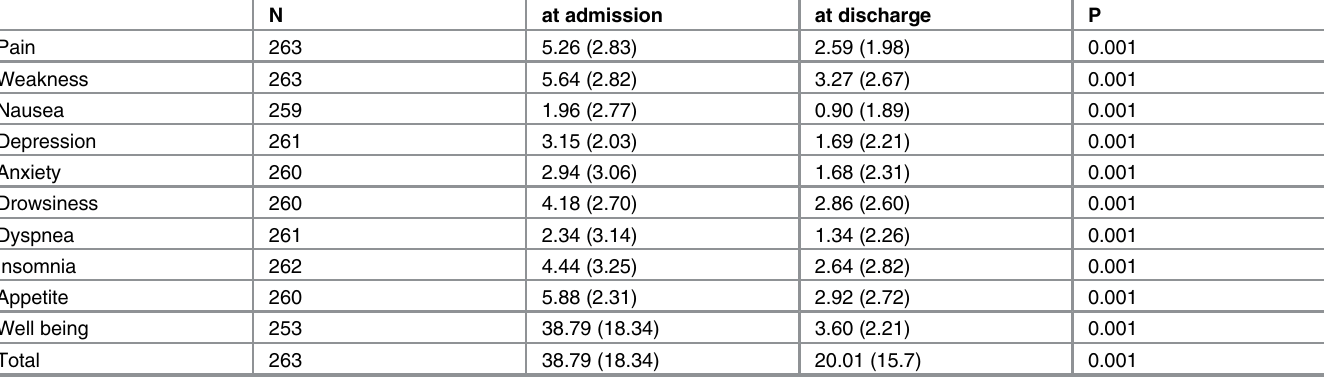
Table 3. ESAS items at admission and at discharge in patients with complete